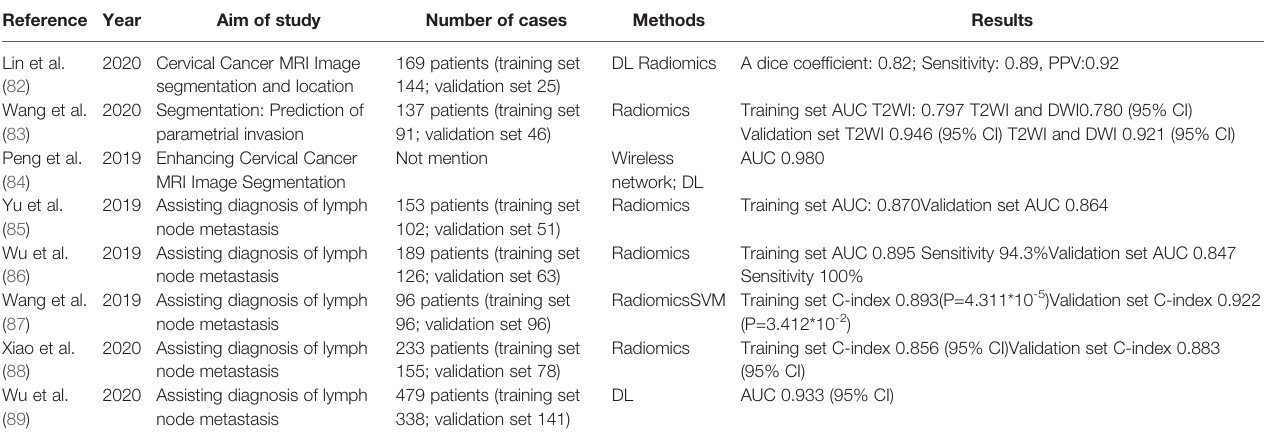
TABLE 7 | Application of AI in MRI to diagnosis cervical